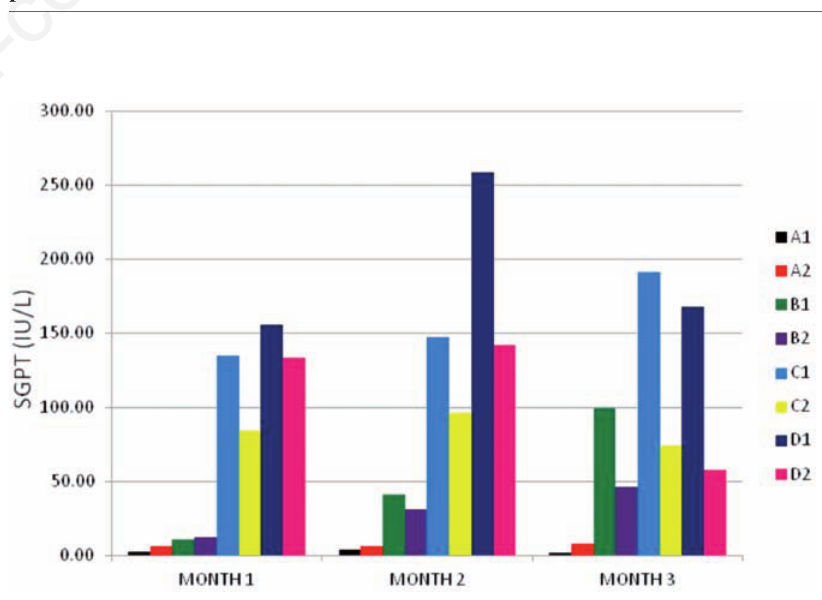
Figure 2. Alanine aminotranferease (SGPT enzyme) activity values for 3 months study